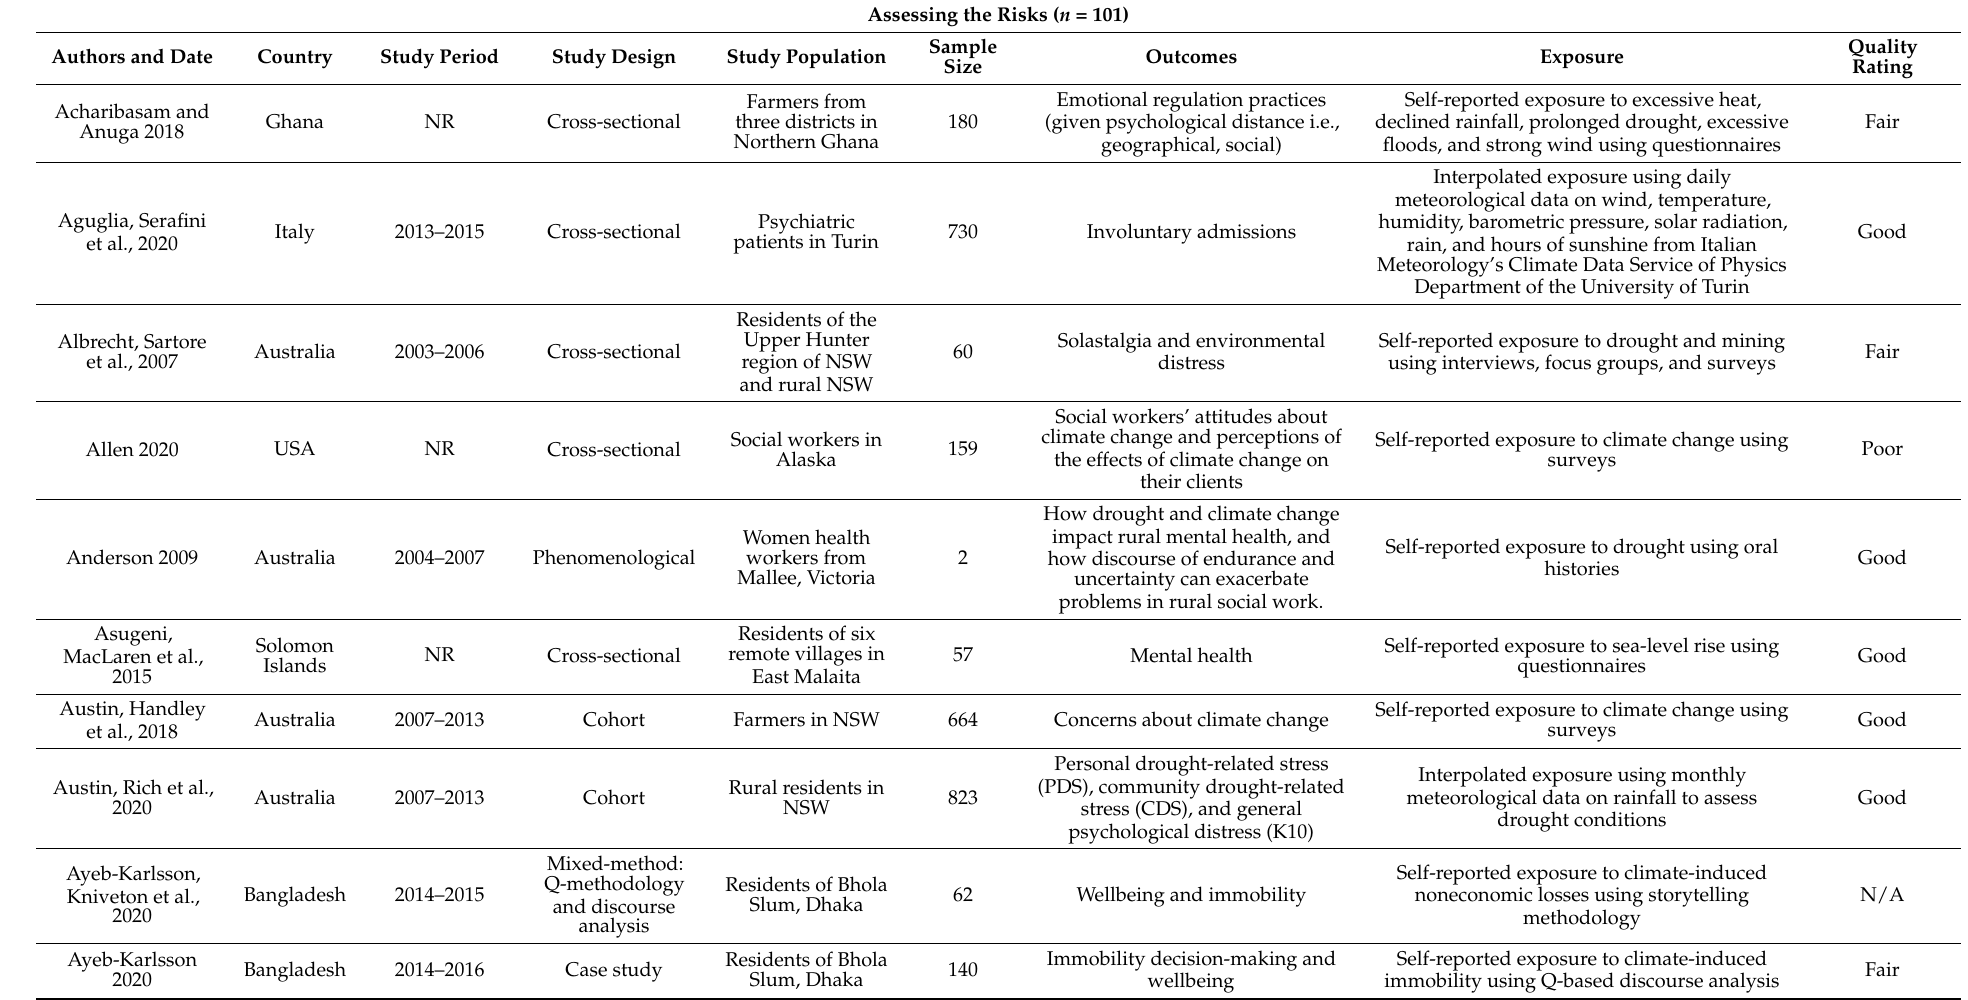
Table A1. Summary of original research (N =